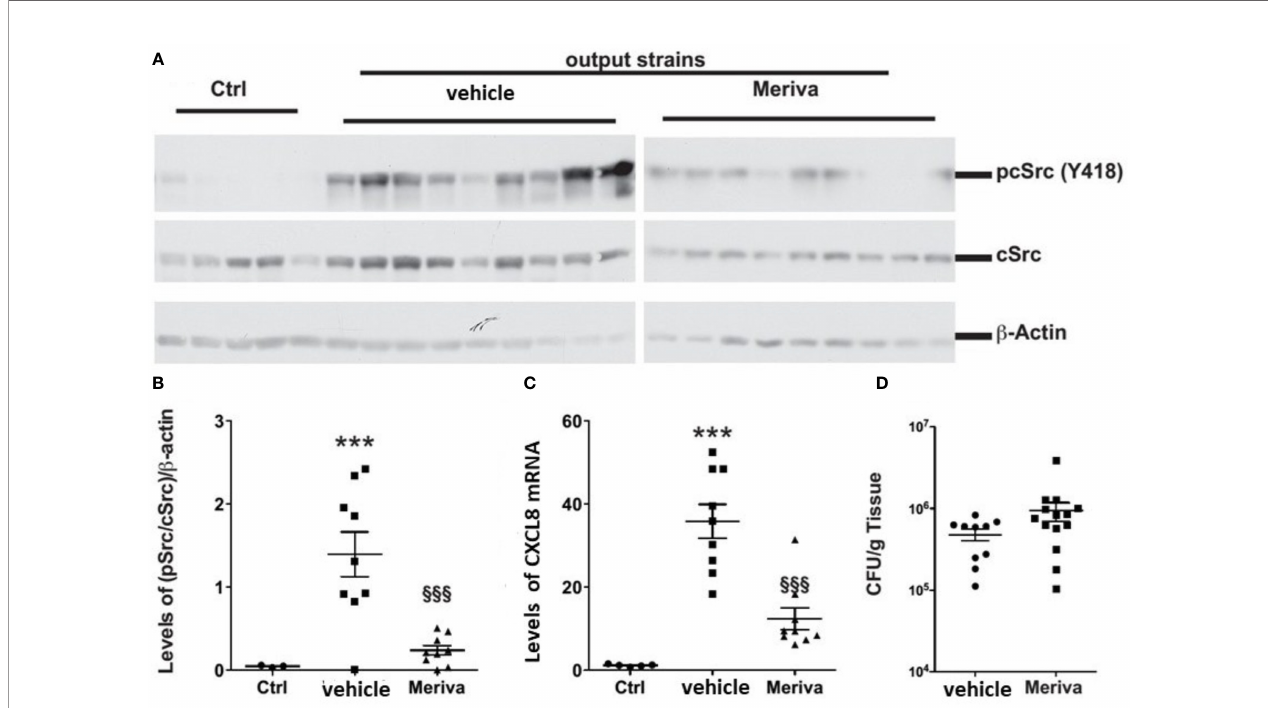
FIGURE 7 | H. pylori output strains isolated from dietary curcumin-treated mice induce attenuated host response. (A) Western blot analysis of cSrc phosphorylation in AGS cells treated with H. pylori isolated from mice fed control chow (vehicle) or chow containing 1% Meriva. H. pylori -infected mice fed with chow containing 1% Meriva for 4 weeks shows attenuation of phosphorylation of c-Src. (B) Quanti fi cation of p-Src/cSrc in the Western blot samples in (A) showing attenuation. (C) Quanti fi cation of CXCL8 mRNA when co-cultured with AGS cells showing reduced level. (D) CFU per gram of tissue showing no colonization. ***P ≤ 0.001, §§§ P ≤